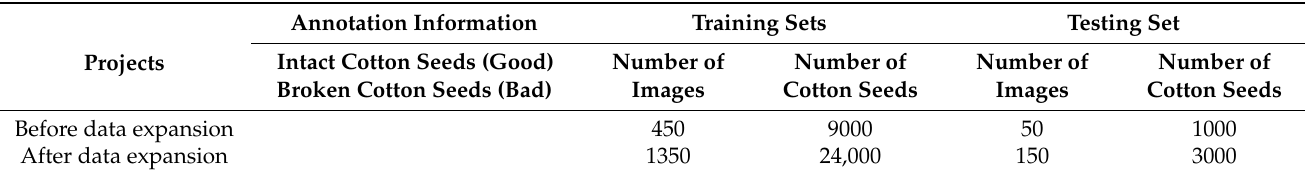
Table 1. Data Table 1. Data sets.